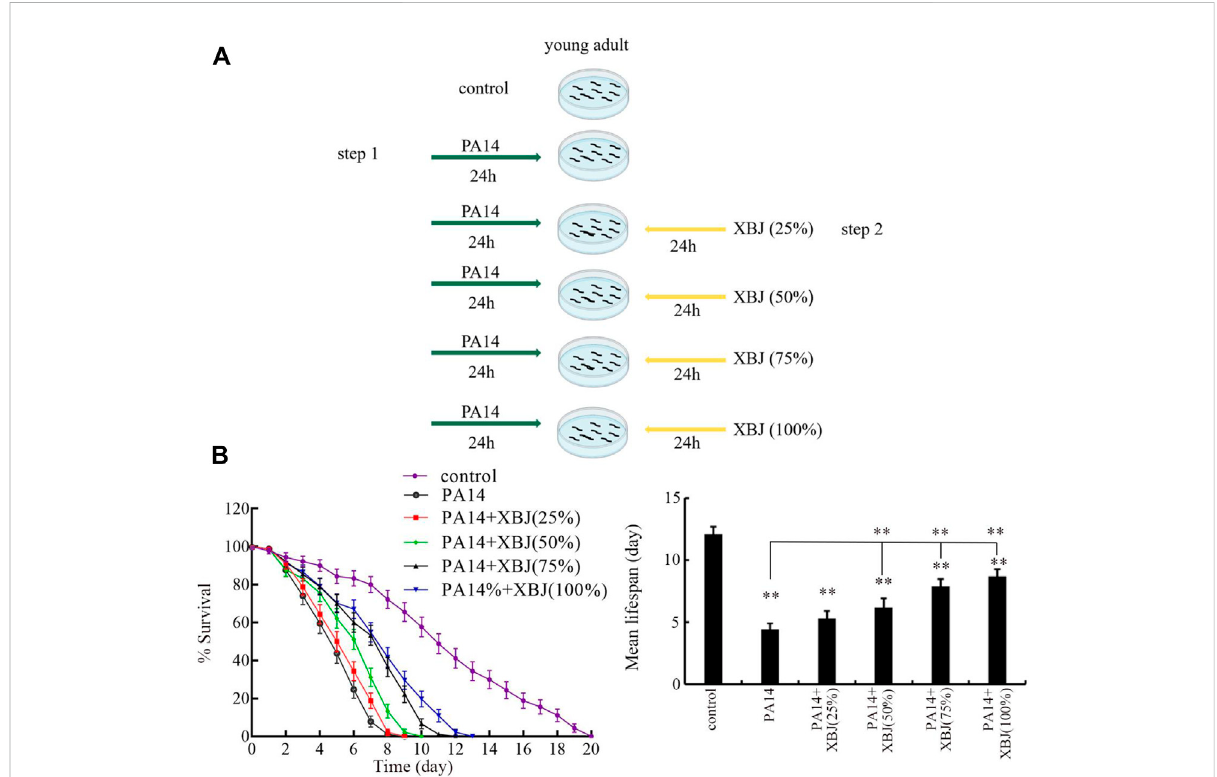
FIGURE 1 Effect of Xuebijing post-treatment against P . aeruginosa infection. (A) Diagram showing the method for pharmacological post-treatment of Xuebijing after P . aeruginosa infection. (B) Effect of Xuebijing post-treatment on lifespan of nematodes after P . aeruginosa infection. XBJ, Xuebijing. ** p < 0.01 vs. control (if not specially